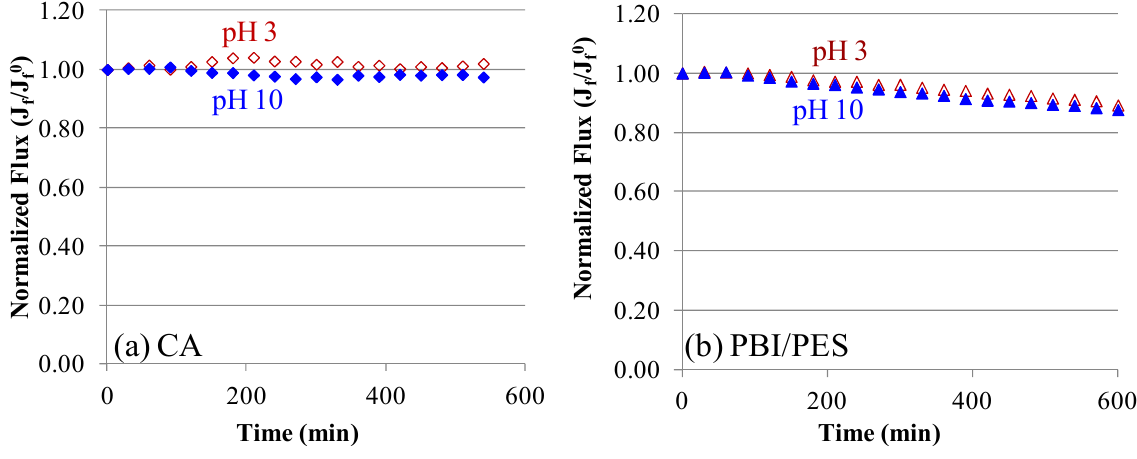
Figure 6. In order to compare the pH effects on CA and PBI materials, baseline experiments of CA and PBI/PES hollow fiber membranes were conducted under the FO mode. ( a ) CA membranes at pH 3 and pH 10; and ( b ) PBI/PES membranes at pH 3 and pH 10. On both CA and PBI membranes, there is no difference in flux caused by the various pH values of solutions. (The baseline solution on the shell side contained , 40 mM Na SO and 38 mM NaCl with a cross-flow velocity of 23 cm/s 70 mM MgCl 2 2 4 ( Re = 2992). The draw solution on the lumen side was 2 M MgCl at 24 ± 1 °C. The initial 2 flux of CA is 5.5 ± 0.7 L/m 2 h and of PBI/PES is 11.7 ± 0.7 L/m 2